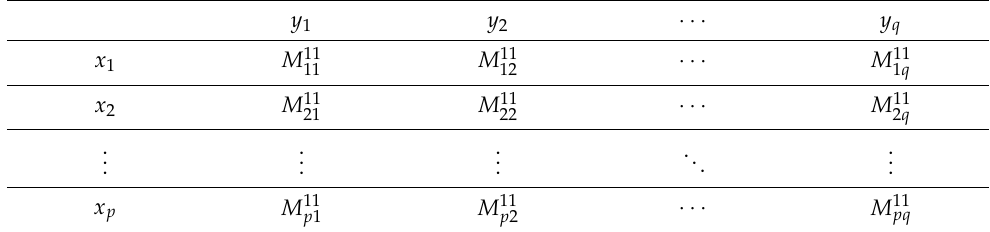
Table 1. Decision matrix for class k = 1, orthant l = 1, p objects in target class, and q objects in other